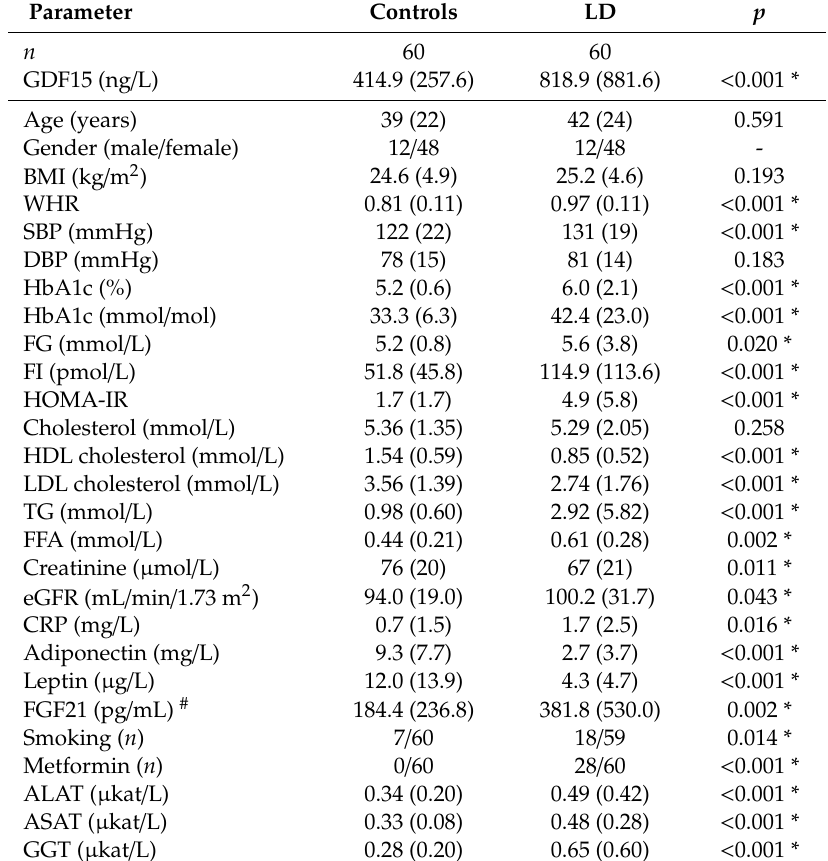
Table 1. Baseline characteristics of the entire study population ( n = 60 controls and n = 60 LD).